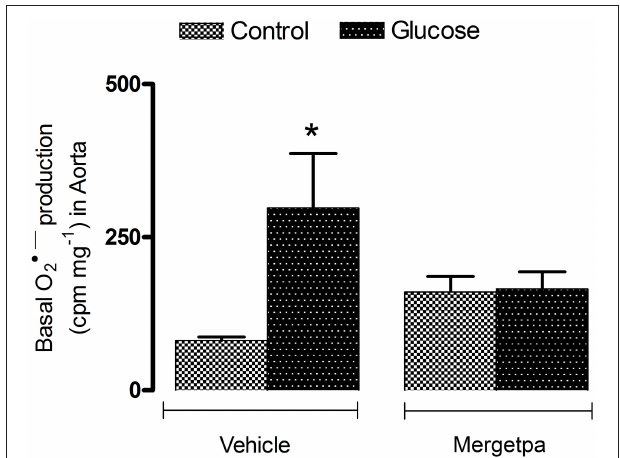
FIGURE 2 | Treatment effect on anion superoxide production. Effect of s.c. administered Mergetpa (1 mg.kg − 1 twice daily) for 7 days on basal superoxide anion production in the thoracic aorta. Data are mean ± SEM obtained from six rats per group. * P < 0.05 compared with control + vehicle. Data in vehicle treated rats are from a previous study (Haddad and Couture, 2016) but performed